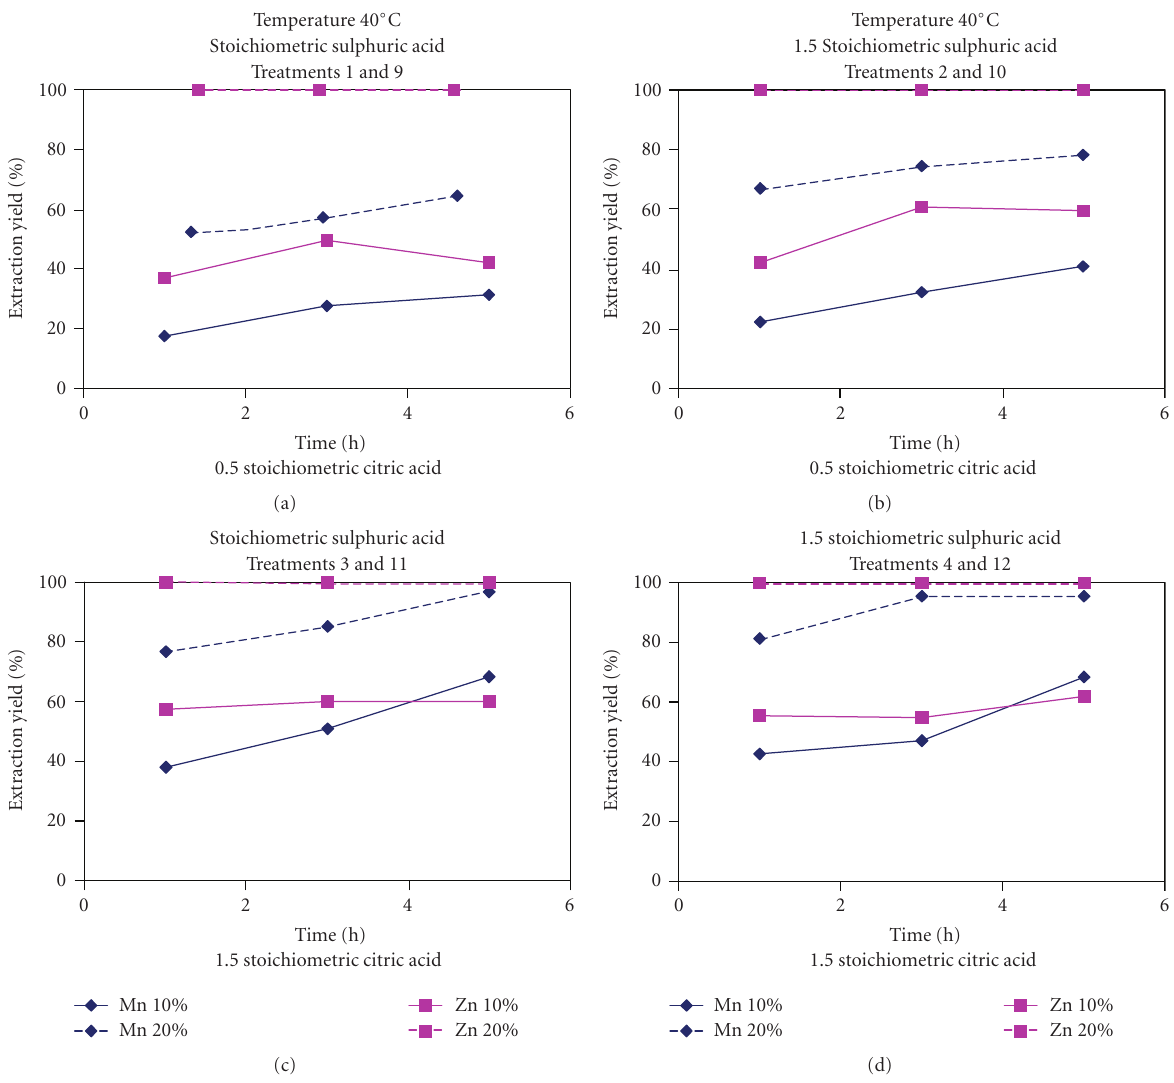
Figure 2: Zinc and manganese extraction yields versus time profiles during exhaust battery powder leaching by sulphuric acid solution in the presence of citric acid as reducing agent (temperature 40 ◦ C). See Table 1 for experimental conditions (continuous lines are related to treatments with 10% powder, dotted lines to treatments with 20%